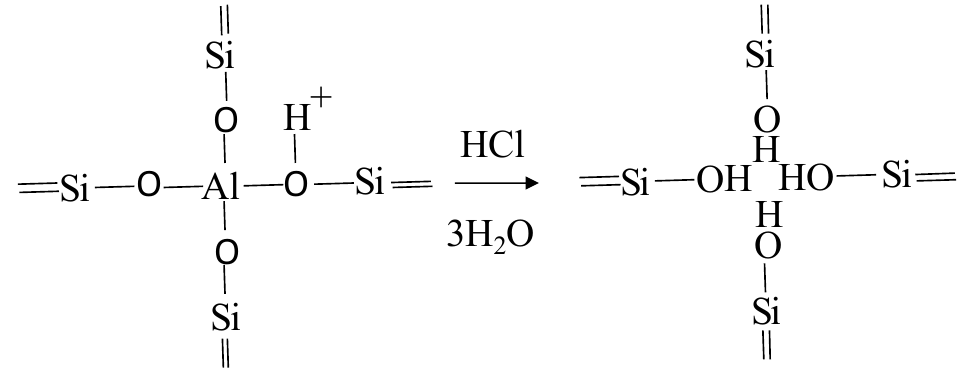
Figure 4. Acid treatment of zeolites.